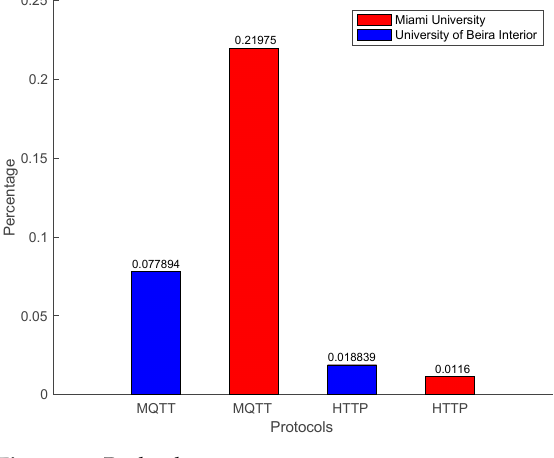
Figure 10. Packet loss.